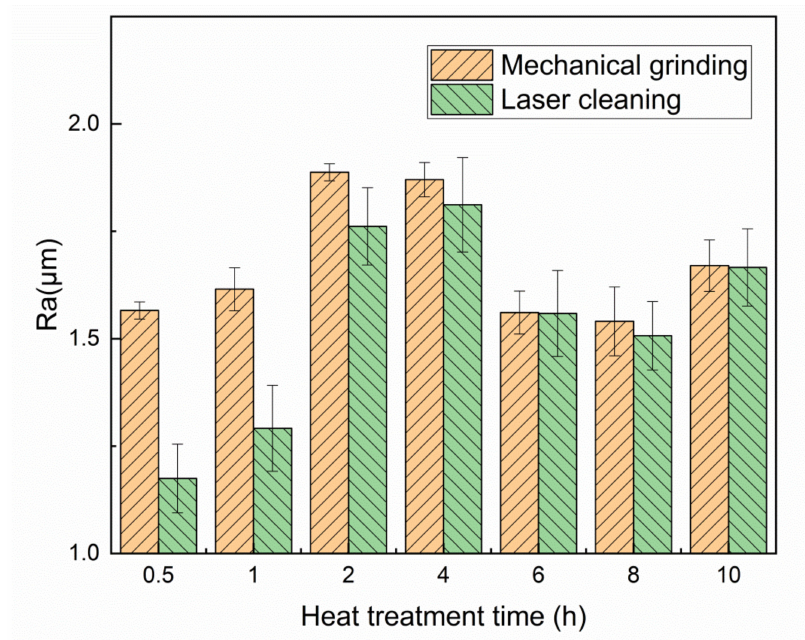
Figure 13. Roughness of surface oxide film at different times with mechanical grinding and laser cleaning.